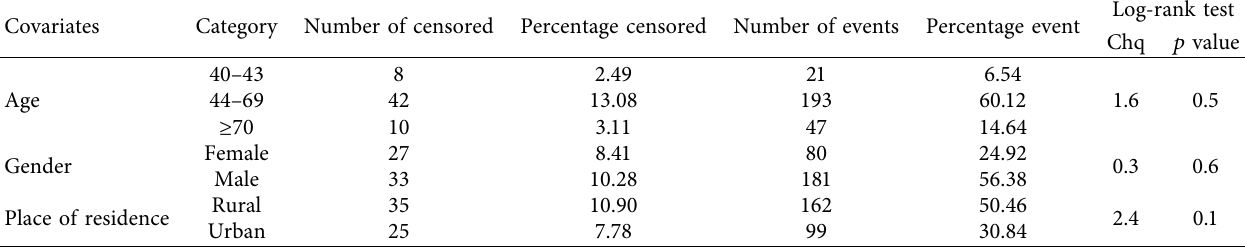
Table 1: Group differences in some sociodemographic factors and glaucoma patient survival patterns at Jimma University specialized hospital, 2016–2020 ( n � 321)).